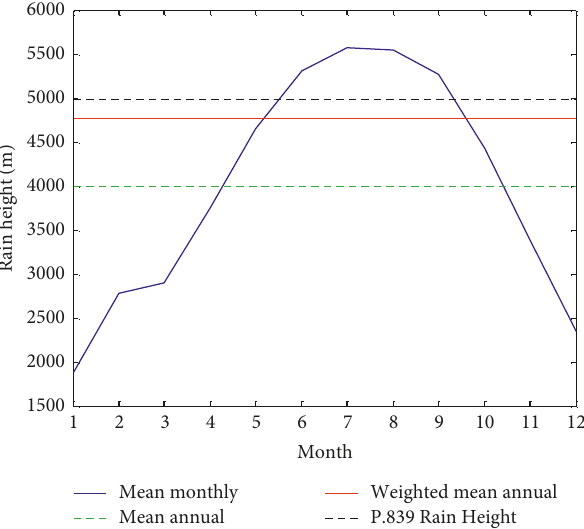
Figure 2: Comparison between different mean rain heights in Qingdao,